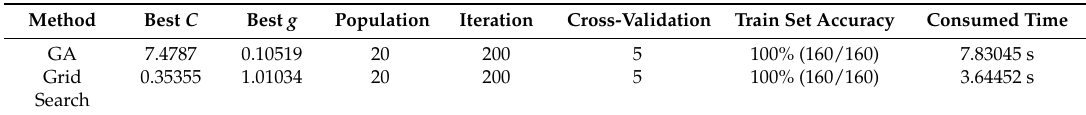
Table 1. Parameters of Grid Search and genetic algorithm (GA).